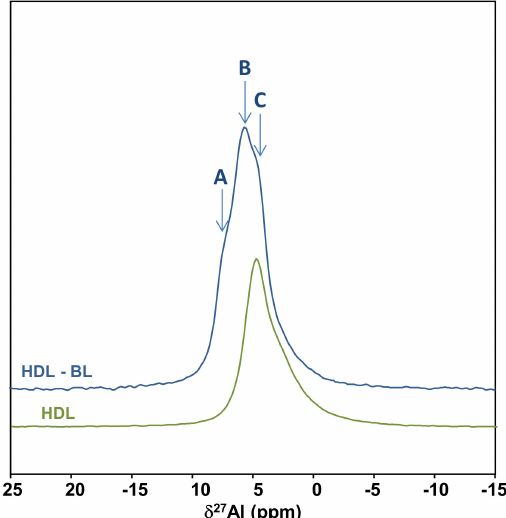
Figure 7. 27 Al MAS NMR spectrum of LDH-BL (blue) and pure LDH